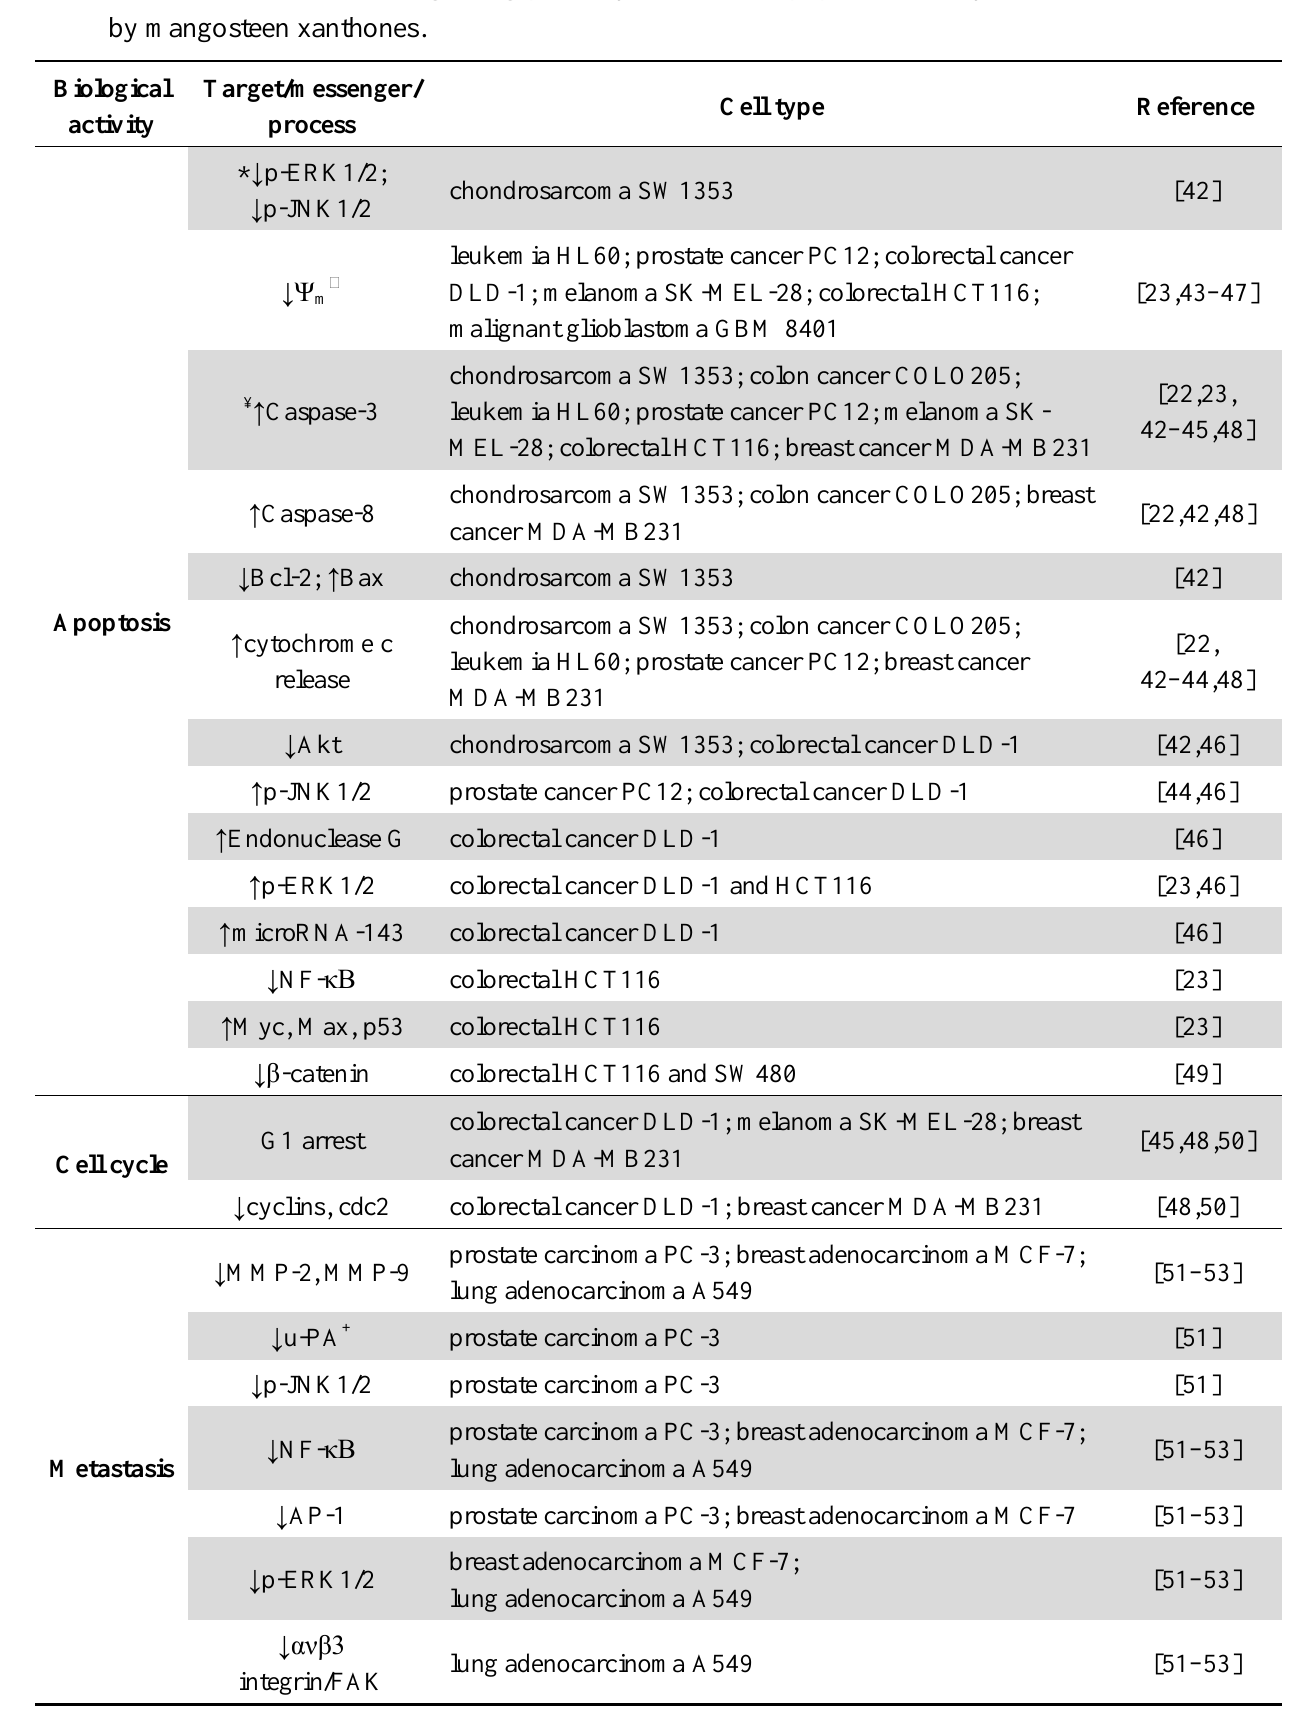
Table 6. Modulation of signaling pathways related to apoptosis, cell cycle and metastasis by mangosteen